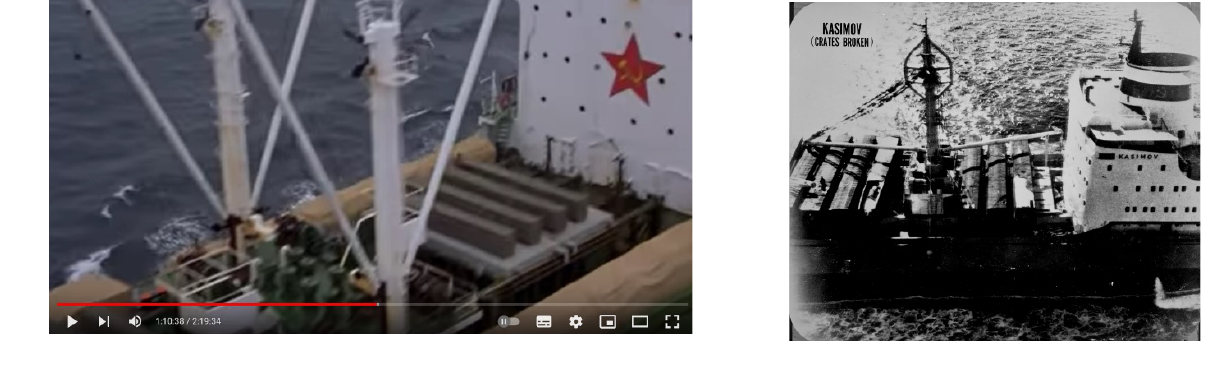
Figure 13 The crates of missiles in Russian freight ship Figure 14 Real Russian ship